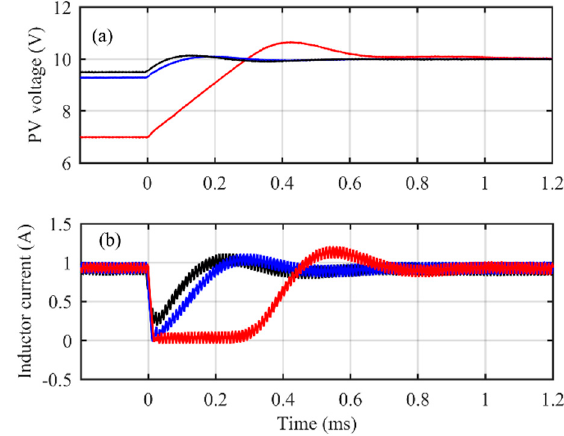
Figure 13. The behavior PVG voltage ( a ) and inductor current ( b ) when step-changes of 0.5 V (black), 0.71 V (blue), and 3 V (red) are applied to the PV-voltage reference of the interfacing converter under PID-type control in CCR.